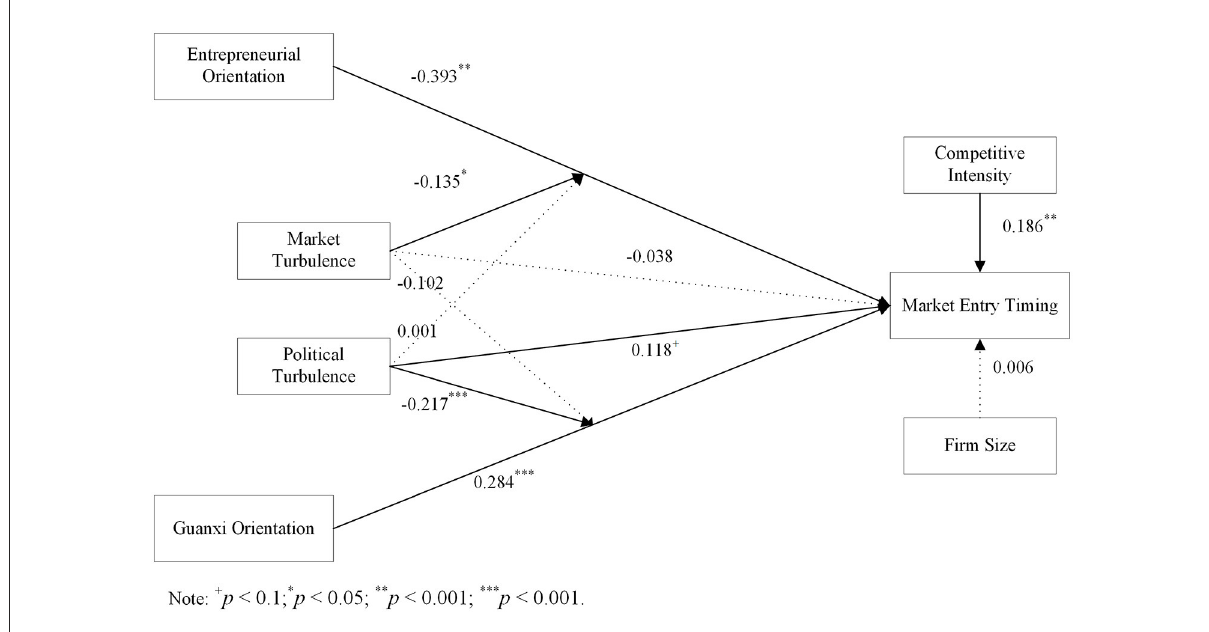
FIGURE2 Results of the structural